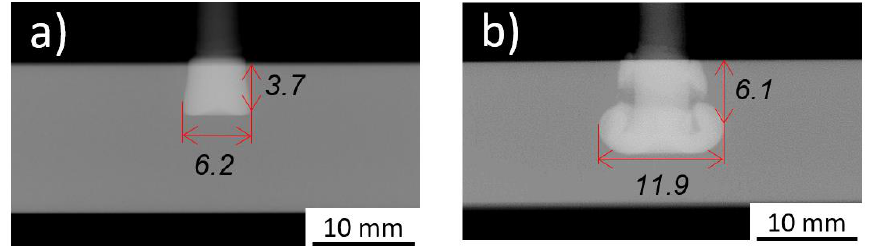
Figure 5. X-ray tomography of: ( a ) Condition 1 with lowest energy input, E M = 24 J (RS = 18,000 rpm; FT = 1.6 s; FoT = 1 s; FF = 2000 N; FoF = 5100 N); and ( b ), Condition 16 with highest energy input, E M = 208 J (RS = 20,000 rpm; FT = 2 s; FoT = 2 s; FF = 3000 N; FoF = 5100 N).